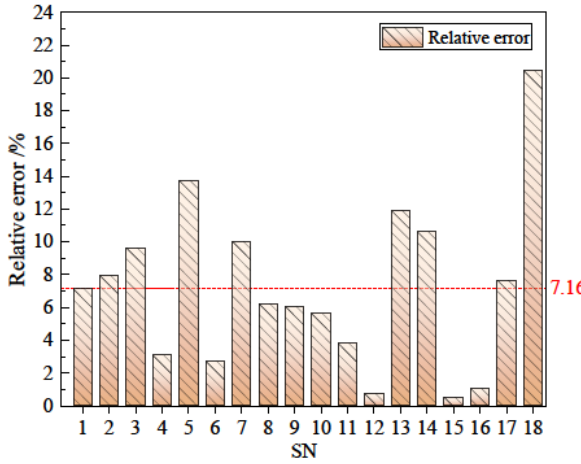
Figure 8: Histogram of relative errors of 28d compressive strength